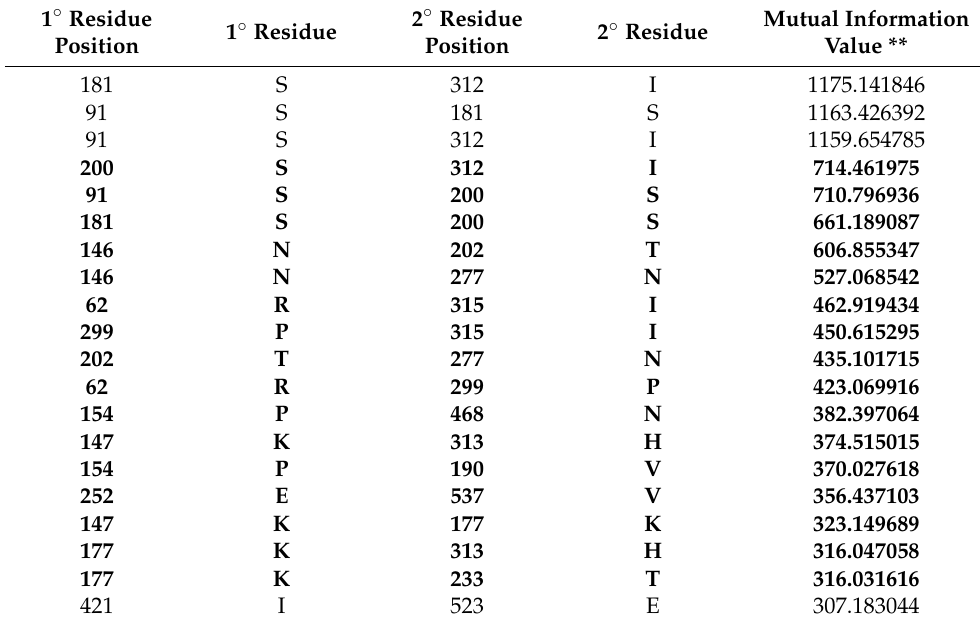
Table 6. Mutual information coevolution for the 20 highest-scoring pairs of residues